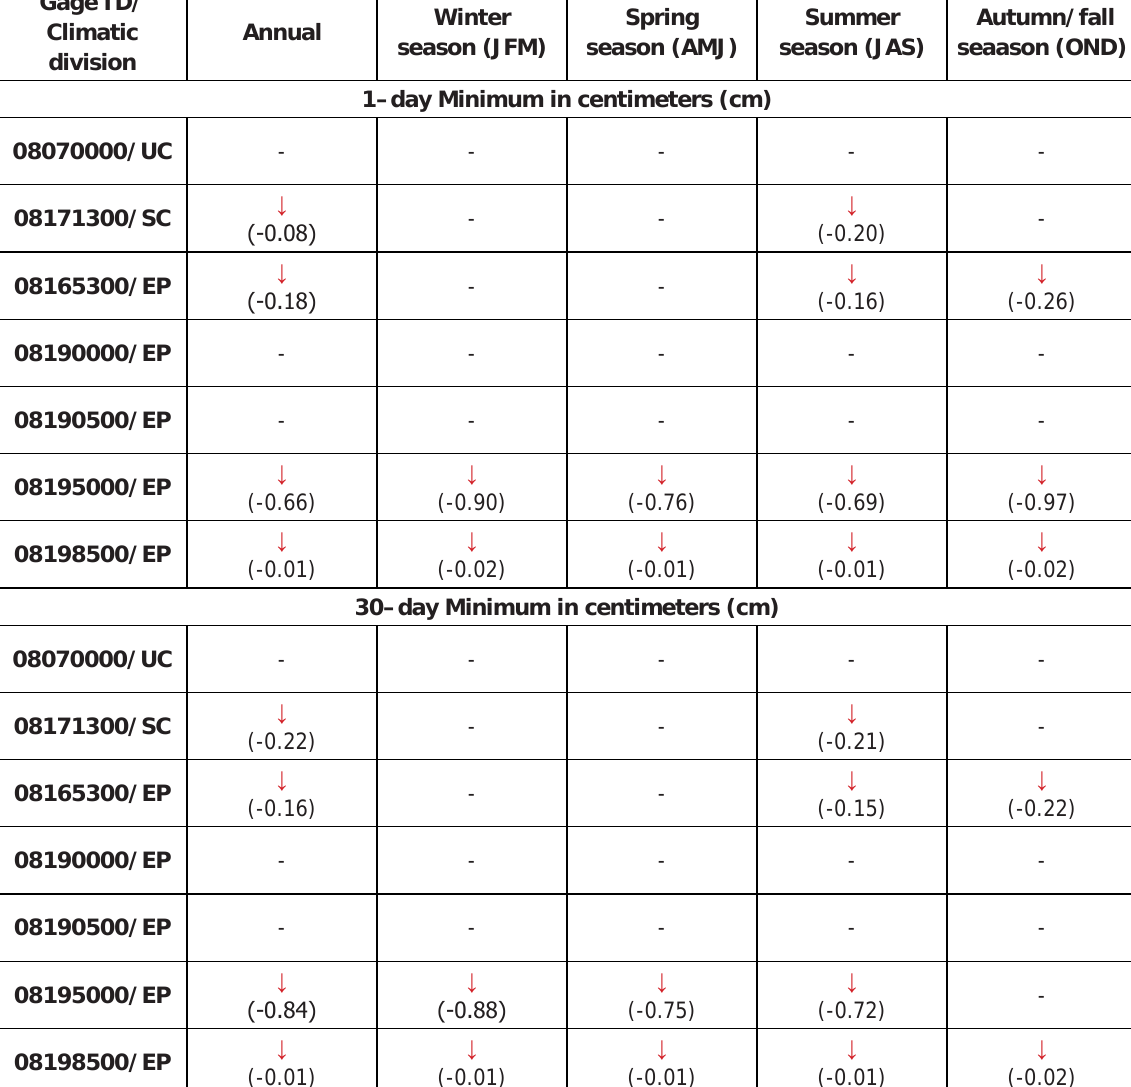
Table 3. Summary of annual and seasonal trends at the selected sites analyzed using the MMK test. Sen slope values are shown in parentheses where trends were statistically significant (significance assessed at p≤0.05; centimeters [cm] or cubic meters per second [m 3